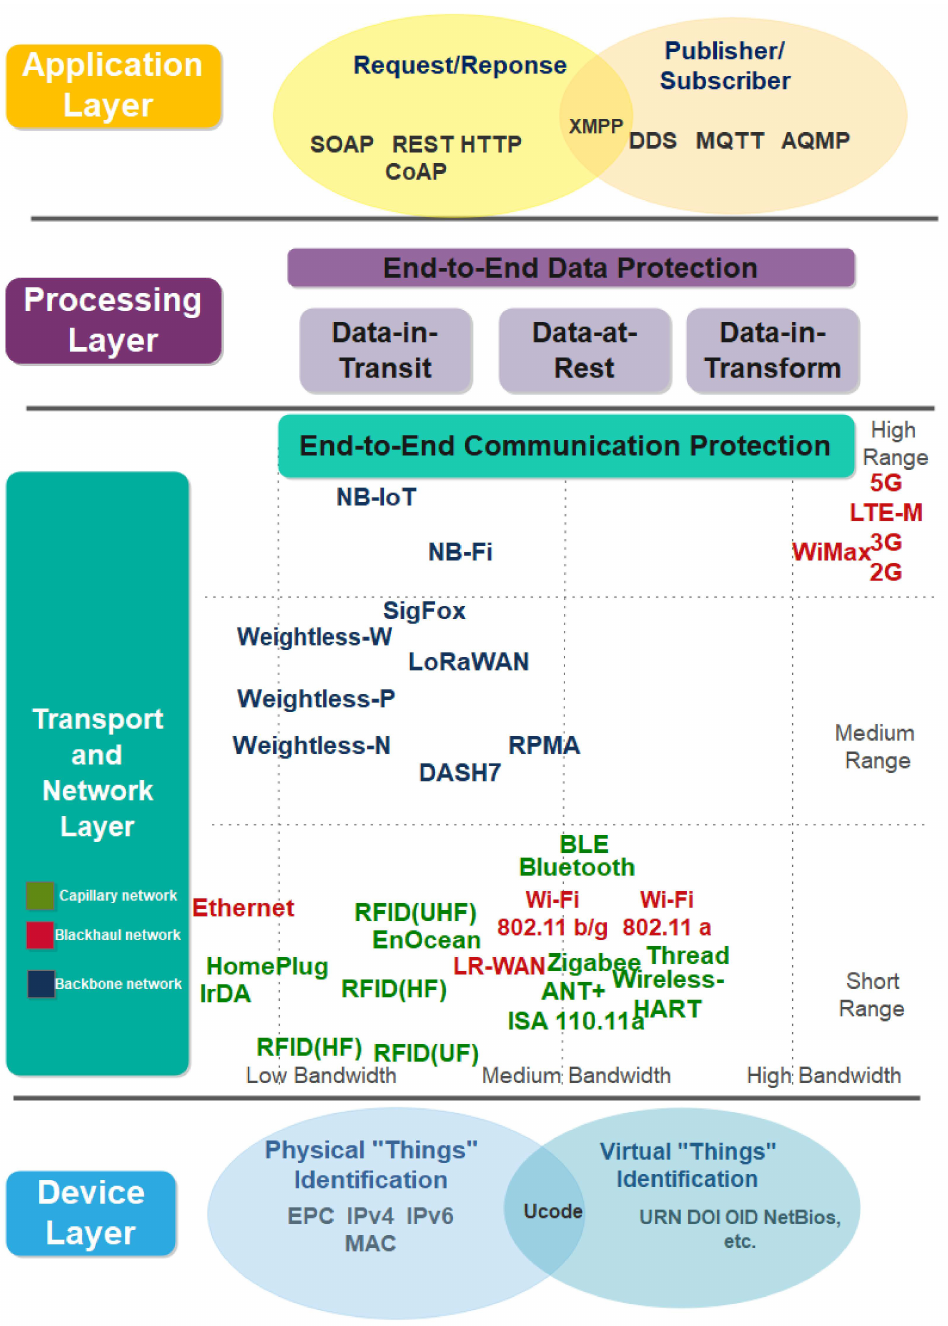
Figure 2. The proposed IIoT security